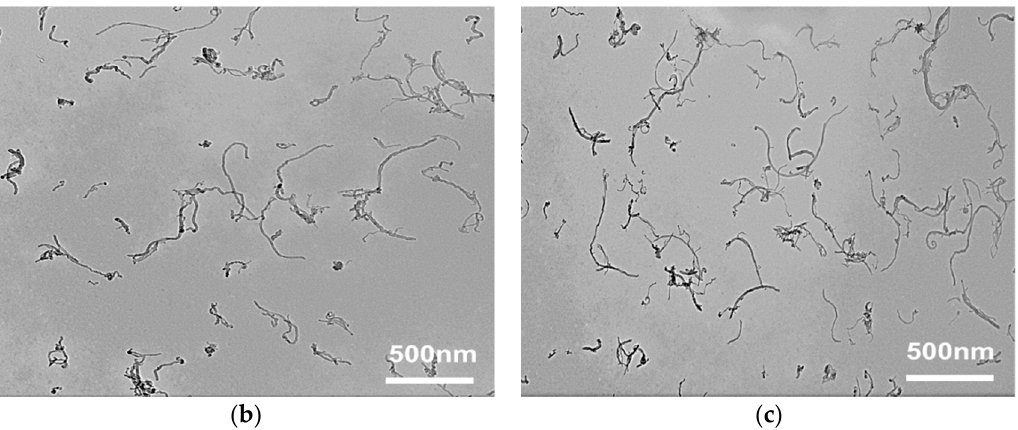
Figure 4. Transmission electron microscopy (TEM) photographs of ( a ) MWCNT-NH 2 , ( b ) MWCNT-BuGE and ( c ) MWCNT-BeGE.